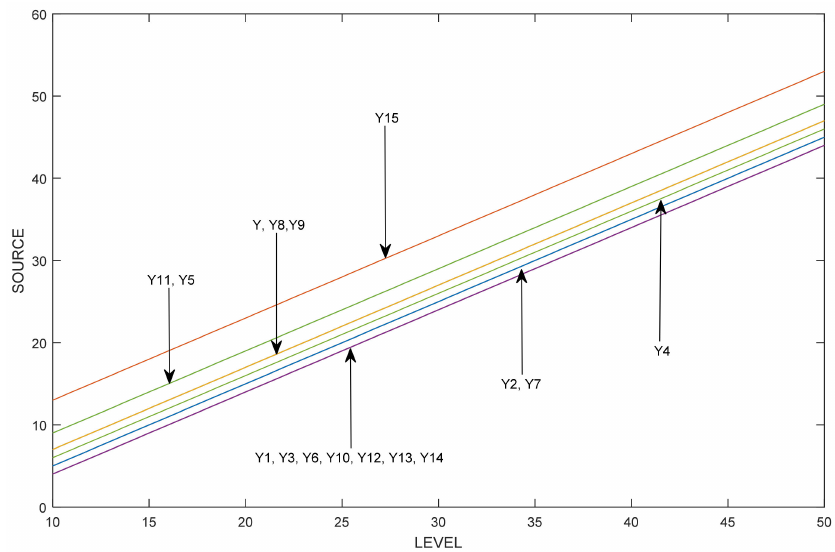
Figure 5. Graph of N DC-SOURCE versus N LEVEL